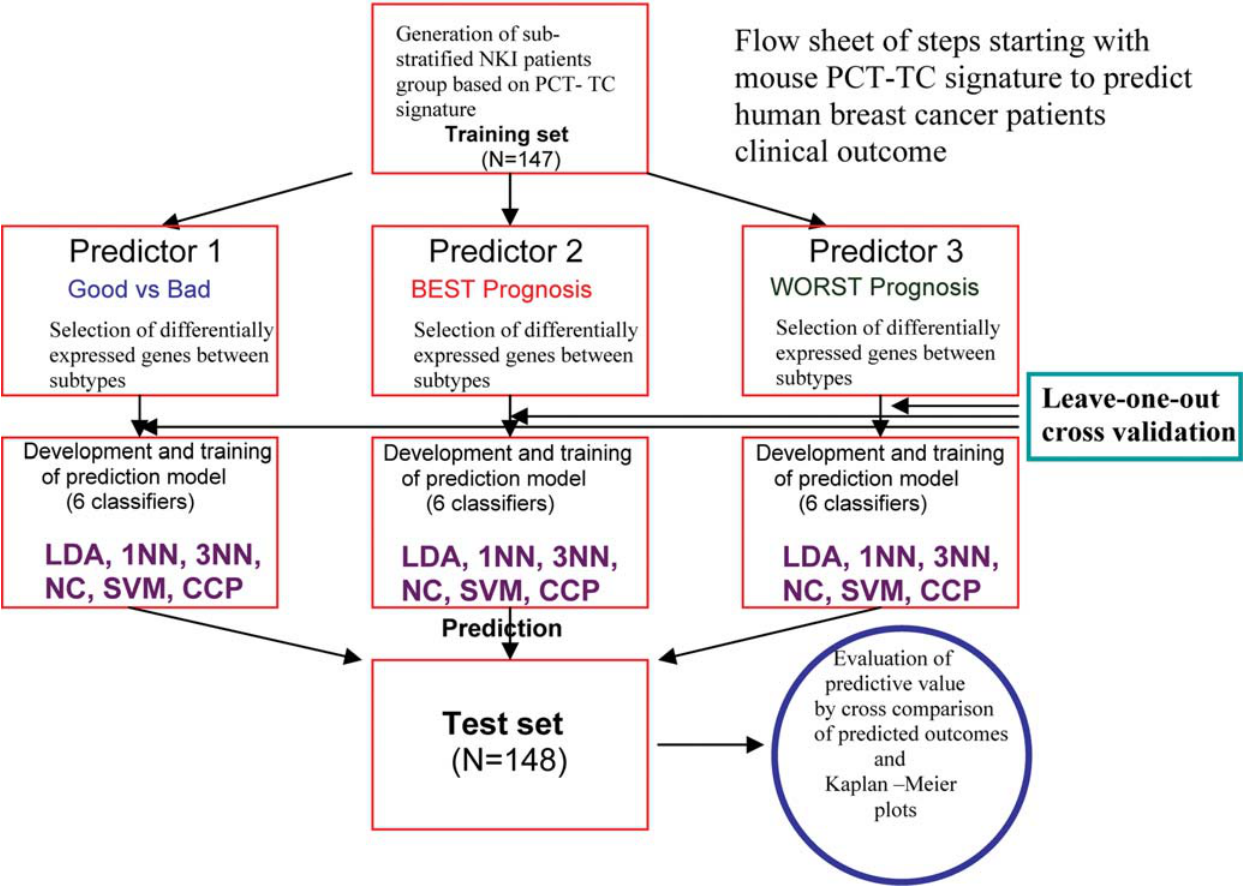
Figure 3. Overview of strategy for the construction of prediction models and evaluation of outcomes. Based on the unsupervised cluster analysis results, 3 independent prediction models are generated.